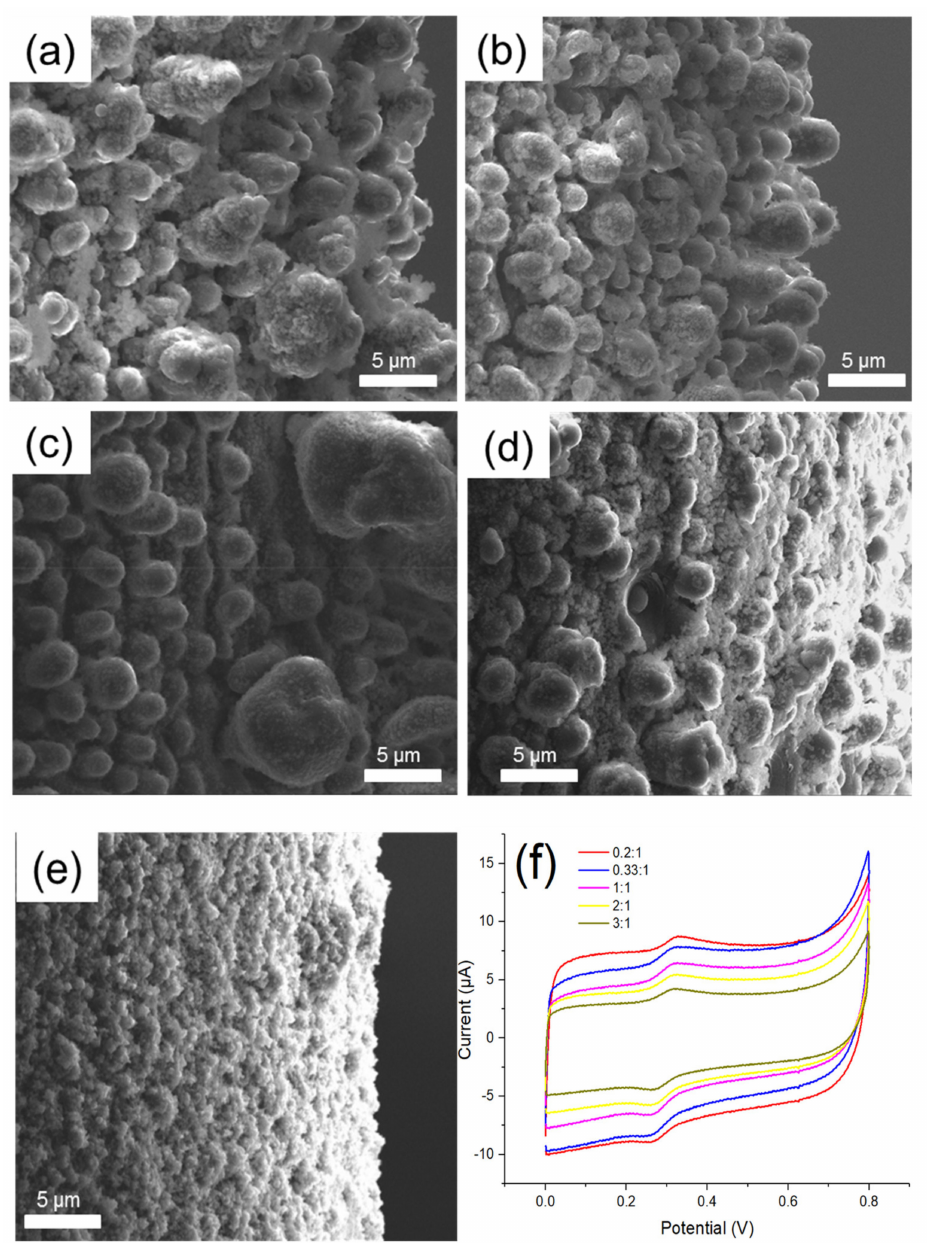
Figure 5. The SEM images of MOF525 / PEM composites synthesized with various EDOT-MeOH / EDOT ratios: ( a ) 3:1; ( b ) 2:1; ( c ) 1:1; ( d ) 0.33:1; ( e ) 0.2:1; and ( f ) the CV traces of MOF525 / PEM composites modified microelectrode synthesized under various EDOT-MeOH / EDOT